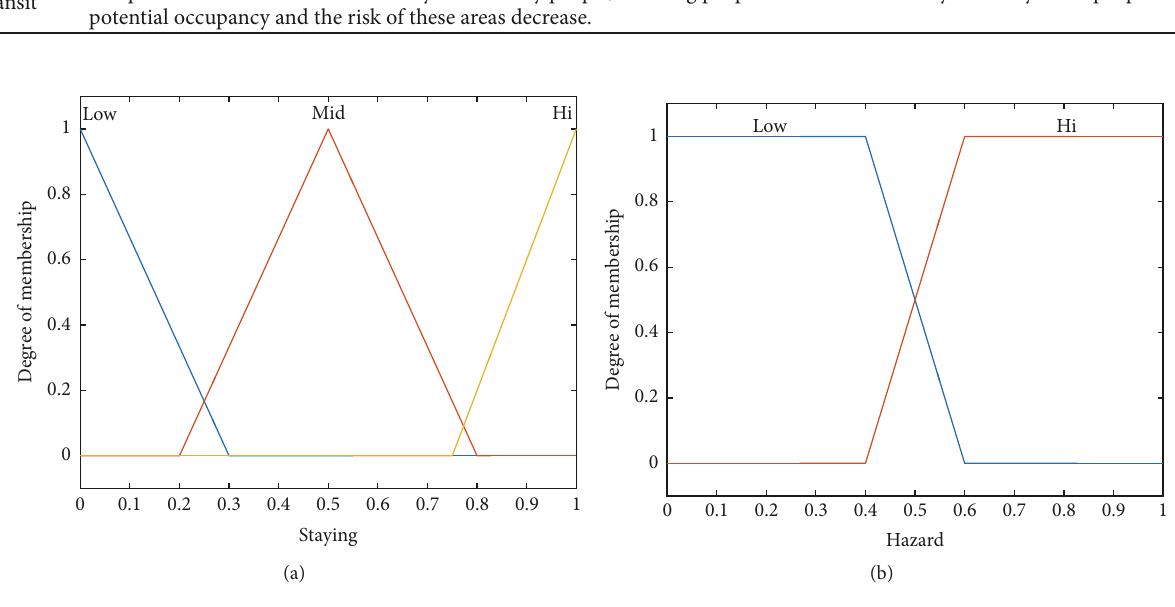
Figure 2: Staying (a) and hazard (b) fuzzy